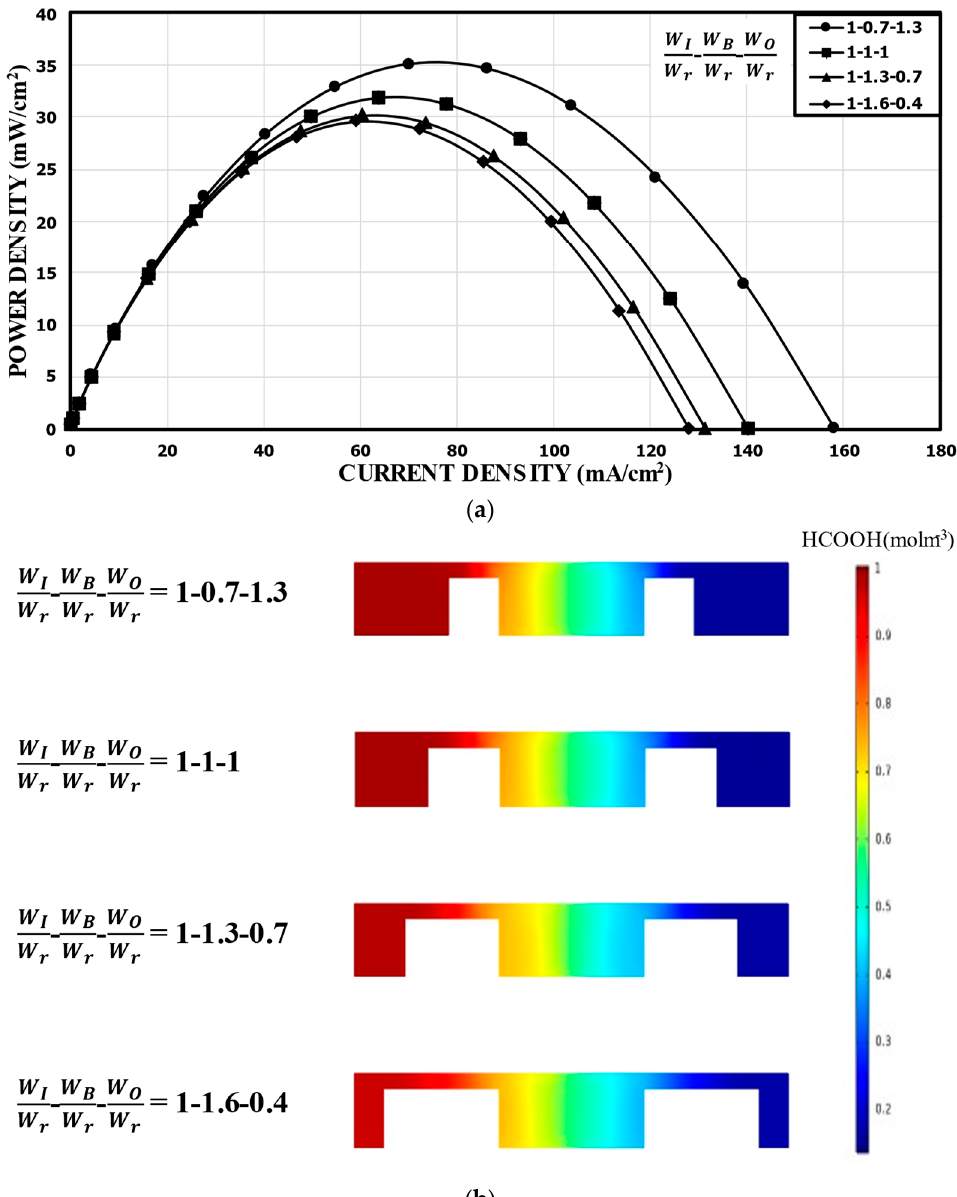
Figure 6. Power density curves for fixed W I : ( a ) performance curves; ( b ) concentration contours of fuel (HCOOH) at the xz plane, 5 mm from the channel inlet.